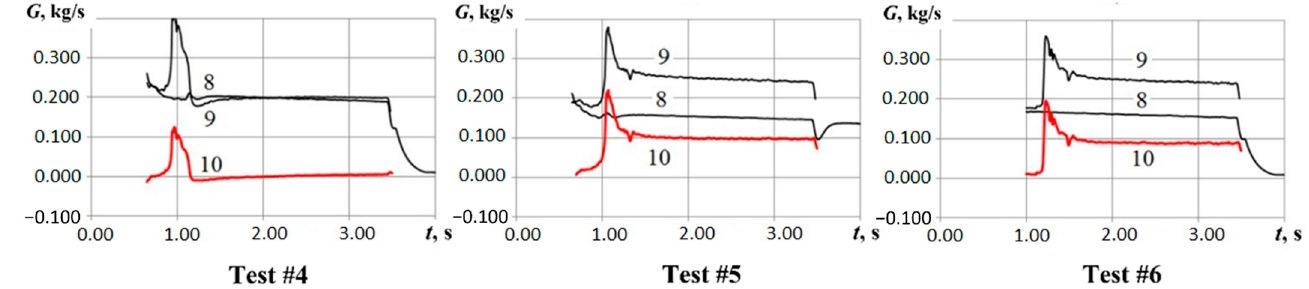
Figure 10. Calculated time histories of flow rates G in (curve 8), G out (9) and Δ G = G out ( t ) − G in ( t ) (10) at М 1 = 2.94 in tests 4 to 6.